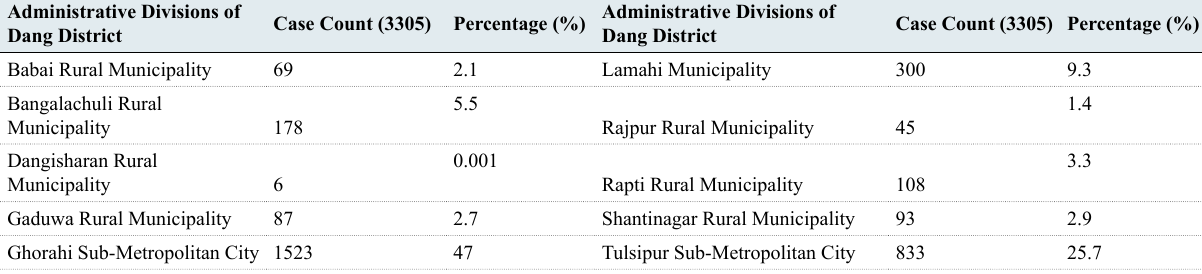
Table 1: COVID-19 Case Count Within Dang by Administrative Subdivisions Administrative Divisions of Case Count (3305) Percentage (%) Dang District